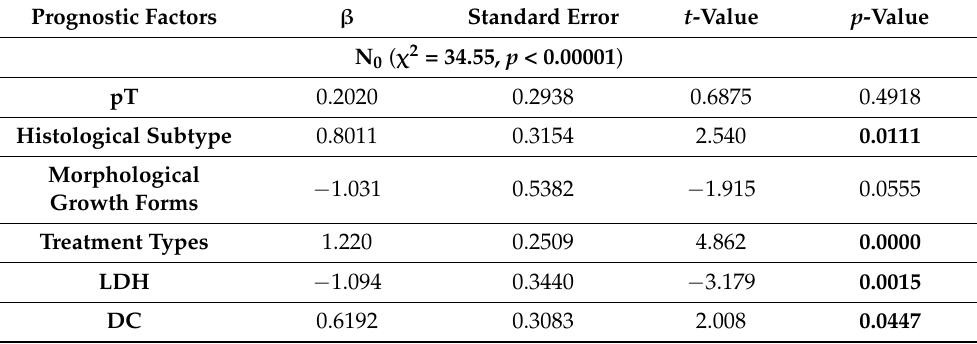
Table 4. Results of multivariate survival analysis using the Cox regression